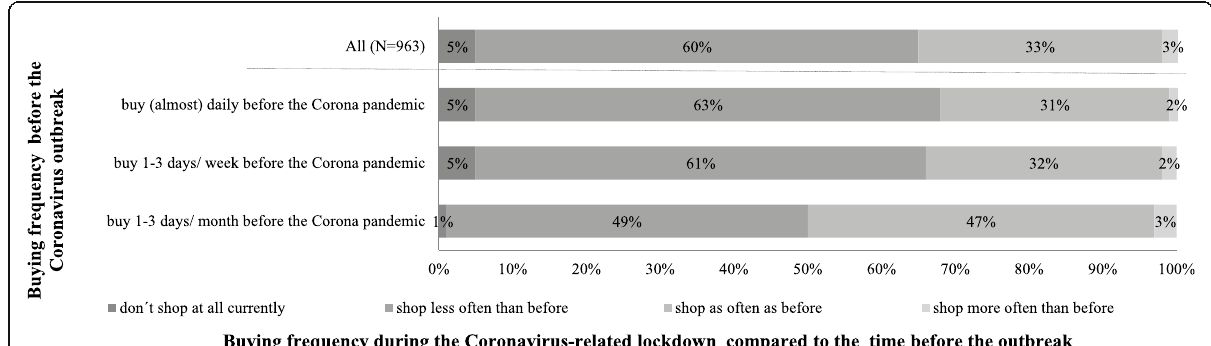
Fig. 1 Buying frequency for daily needs in stores during the Coronavirus-related lockdown depending on buying frequency before the Coronavirus outbreak (only people who buy at least monthly in stores before the Coronavirus pandemic, n = 963)